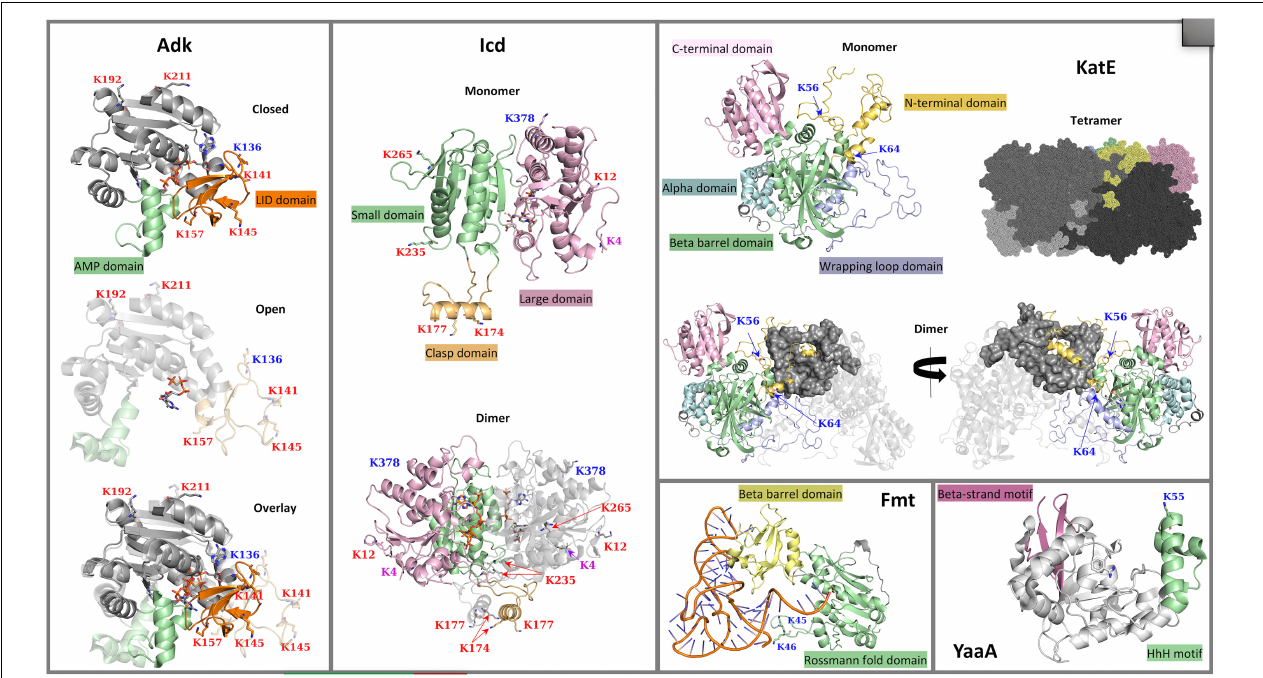
FIGURE 1 | 3D crystal structures of Escherichia coli K-12 lysine acetyltransferase (KAT) substrate proteins (Adk, Icd, KatE, Fmt, and YaaA). The crystal structures of Adk (PDB ID: 1ake and 6f7u) in complex with an AP5A inhibitor or phosphomethylphosphonic acid guanylate ester, respectively, Icd (PDB ID: 1ai2) in complex with NADP + , KatE (PDB ID: 1cf9) in complex with heme, Fmt (PDB ID: 2fmt) in complex with formyl-methionyl-tRNAfMet, and YaaA (PDB ID: 5caj) in complex with benzamidine are shown with ribbon representations. Ligands in each structure are shown with sticks. Lysine (K) acetylation sites are shown with sticks and their labels are colored based on type of acetylation that occurs: KAT sites are in blue, AcP sites are in red, and sites acetylated by both a KAT and AcP are in purple. (Adk) Two conformations of the Adk monomer are shown: the closed (PDB ID: 1ake) and open (PDB ID: 6f7u) conformations are at the top and middle of the panel, respectively; an overlay of the two conformations is shown at the bottom of the panel. The core domain is in gray, the AMP-binding domain is in green, and the ATP-binding LID domain is in orange. (Icd) A single monomer of the Icd structure is shown at the top of the panel with the small domain in light green, the large domain in pink and the clasp domain in orange. The dimeric form of the protein is shown at the bottom of the panel with one subunit colored by domains and the other subunit in gray. (KatE) The KatE protein exists as a tetramer, but a single monomer and dimer of the tetramer are shown to clarify domains and how the monomers of the tetramer intertwine. Each monomer is composed of the N-terminal arm domain in light orange, the C-terminal domain in pink, an alpha-helical domain in light blue, a beta-barrel domain in green, and a wrapping loop domain in violet. One monomer of the dimer is colored in gray, while the other monomer is colored by domains as described. Two views of the dimer are shown and are rotated by 180 ◦ . The tetramer is shown as a surface representation with each monomer colored in varying shades of gray, except for a single monomer that is colored by domains as in the single monomer view. (Fmt) A single monomer of the Fmt protein is shown with the Rossmann fold domain colored in green and the beta-barrel oligonucleotide binding fold domain in yellow; the formyl-methionyl-tRNAfMet is in orange and blue. (YaaA) The YaaA monomer is shown in gray ribbons with the beta-strand motif in pink and the helix-hairpin-helix (HhH) DNA-binding motif in